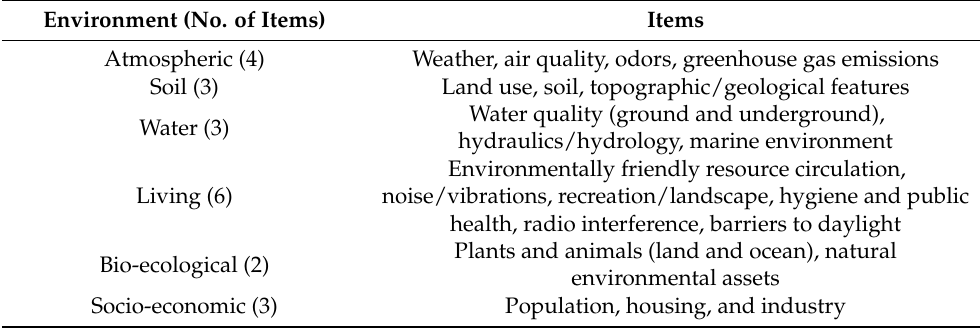
Figure 1. General process of EIA and stages with public involvement based on the environmental impact assessment. Table 1. Six environments and associated items covered by an EIA in South Korea (Environmental Impact Assessment Act, 2018).